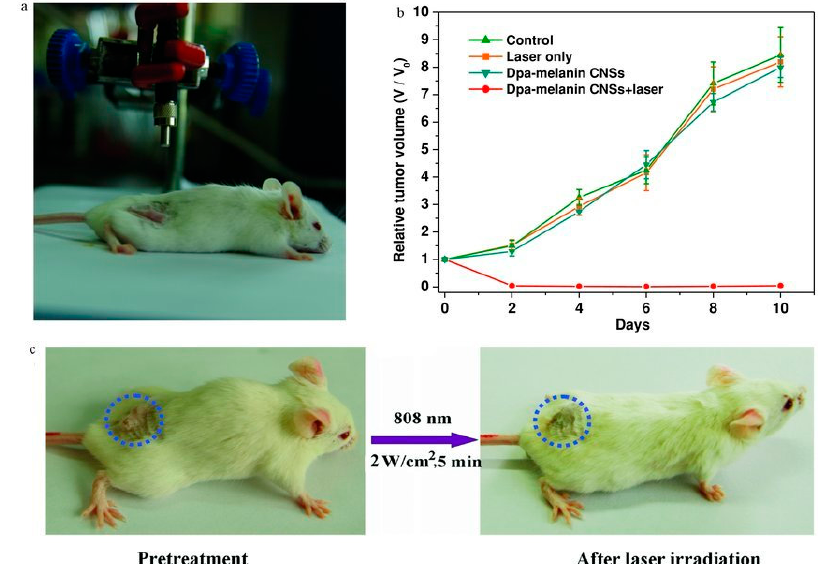
Figure 7. Laser set up for photothermal therapy of the tumour-bearing mouse ( a ). Relative tumour volume over 10 days comparing the di ff erent treatments: Control (green line), laser only (orange line), PDA NPs alone (blue line), and PDA NPs irradiated with laser light (red line) ( b ). Photos of a tumour-bearing mouse before and after treatment with the laser set up ( c ). From reference [9]. Reprinted with permission from